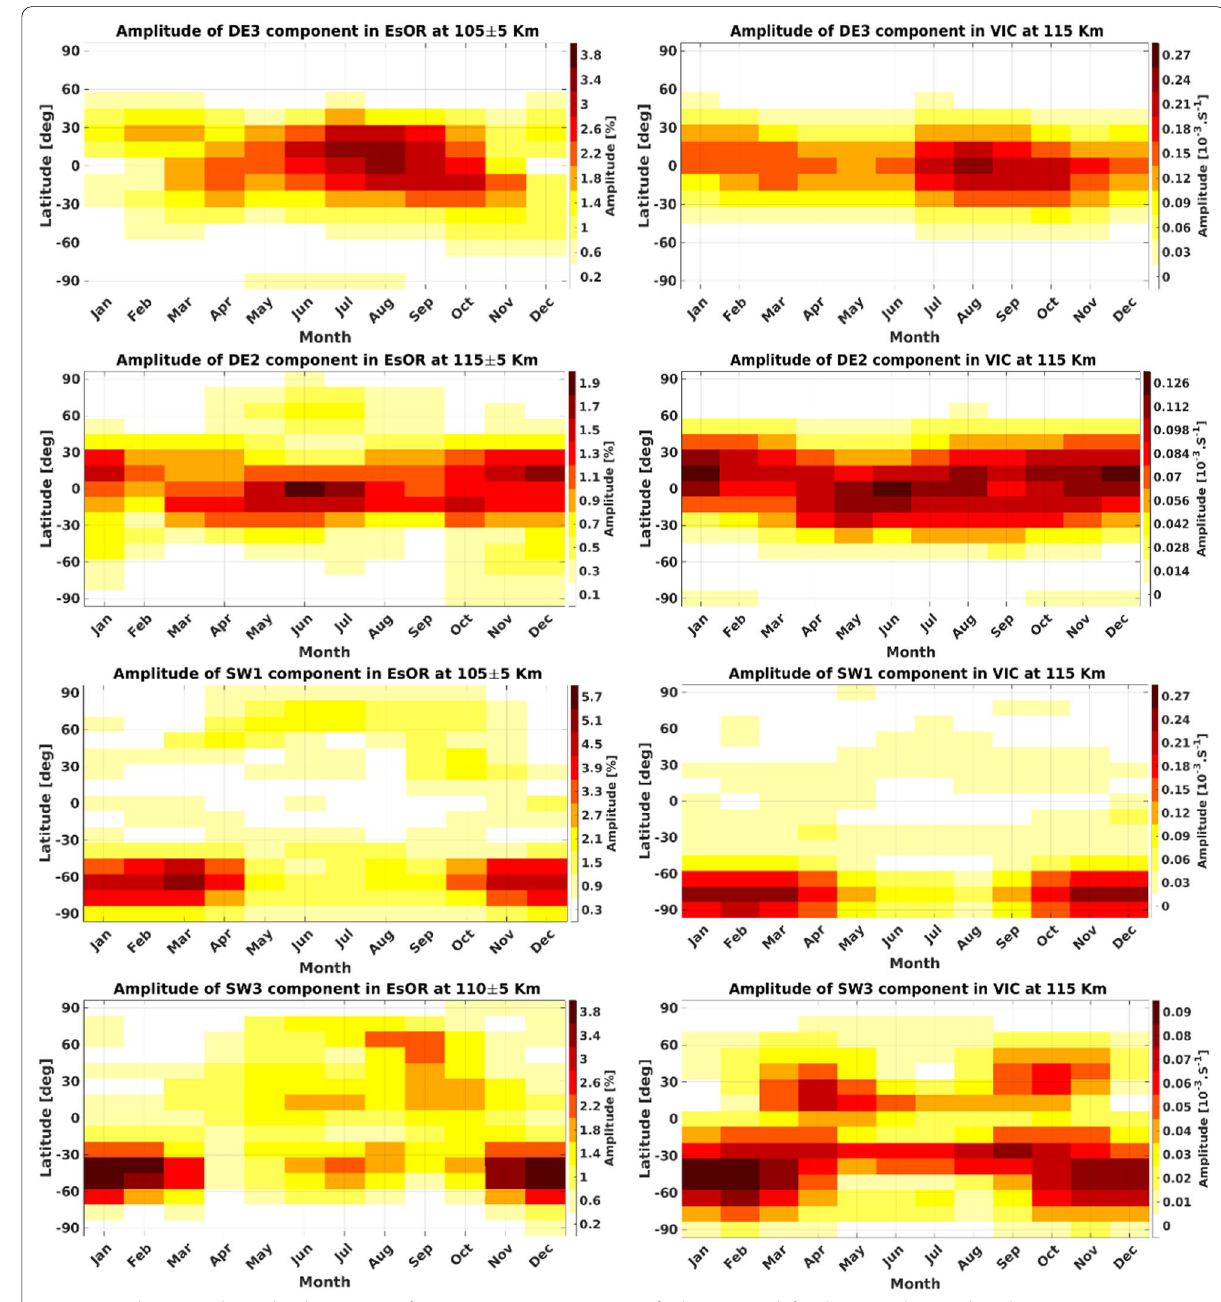
Fig. 7 Month‑to‑month amplitude variation of non‑migrating components of tides in EsOR (left column) and VIC (right